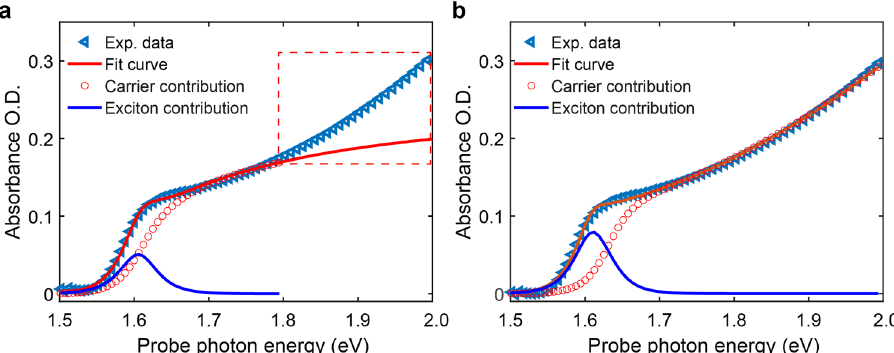
Fig. 1 Steady-state absorption spectrum measurement. Linear absorption spectra and fi ts a without nonparabolic and b with nonparabolic factor ξ . The fi tting range of a is only from 1.5 – 1.8 eV. O.D. is the optical density de fi ned by (cid:2) log optical denisty.